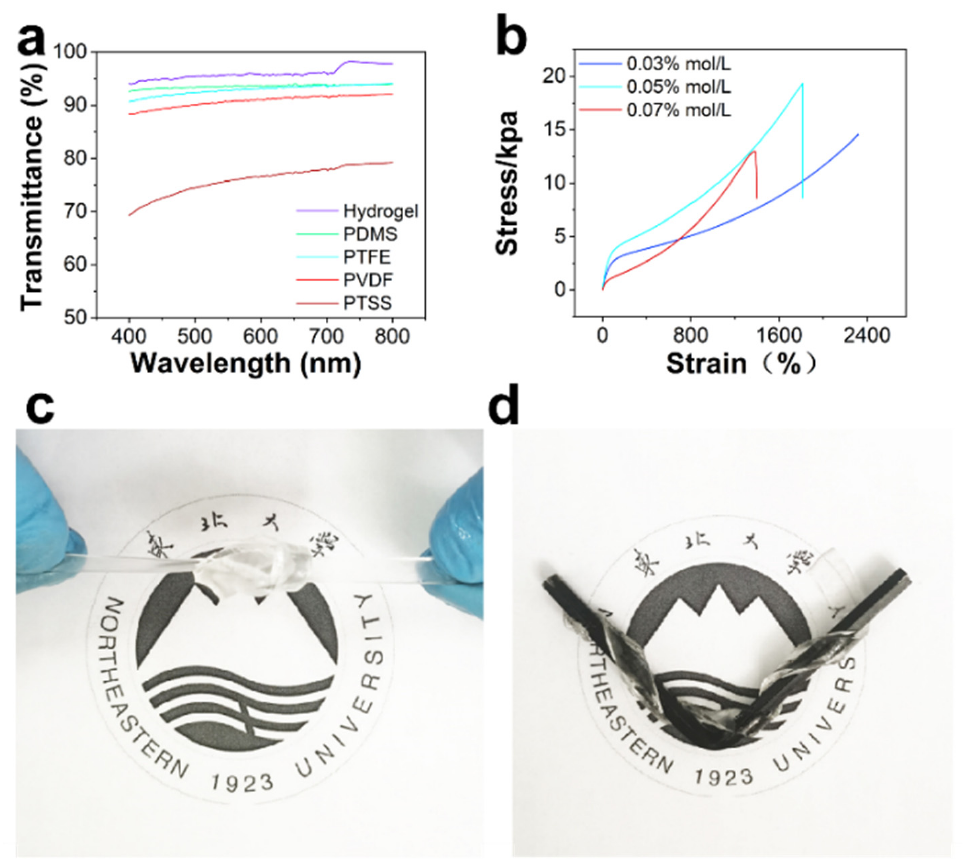
Figure 4. Physical properties of hydrogel ( a ) Transparency of each part of the PTSS. ( b ) Stress-strain curve of different APS ratios of hydrogel. ( c , d ) Scene of stretching hydrogel in any shapes. As a motion monitoring sensor, its sensing accuracy and size, including bend an- gle, frequency, and twist angle should be taken into account. Usually, water sports are